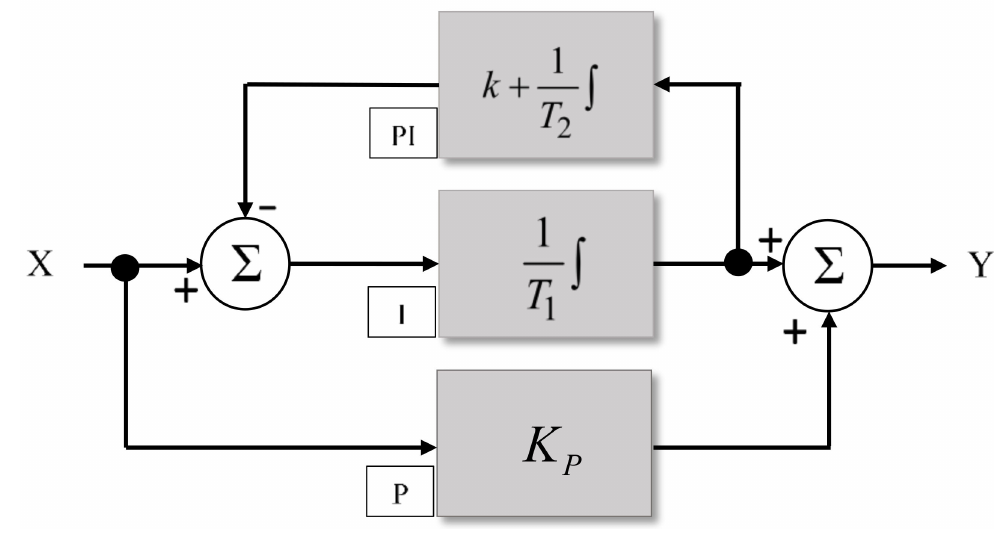
Figure 5. Parallel structure of a real P+R controller.